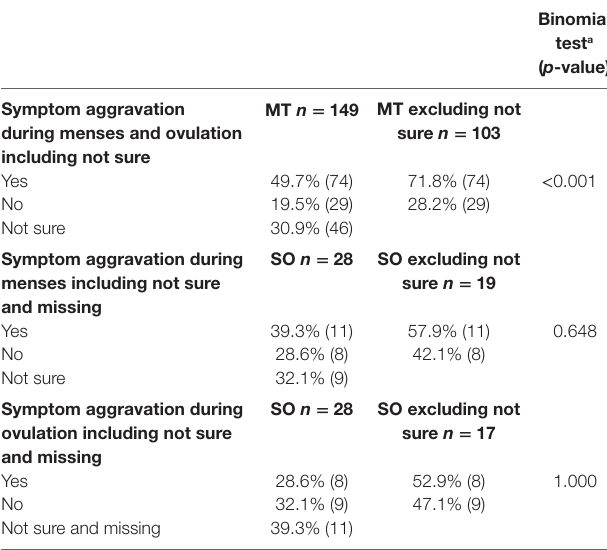
Table 5 | Reported aggravation of symptoms during menses and ovulation, presented as a percentage of the group and raw